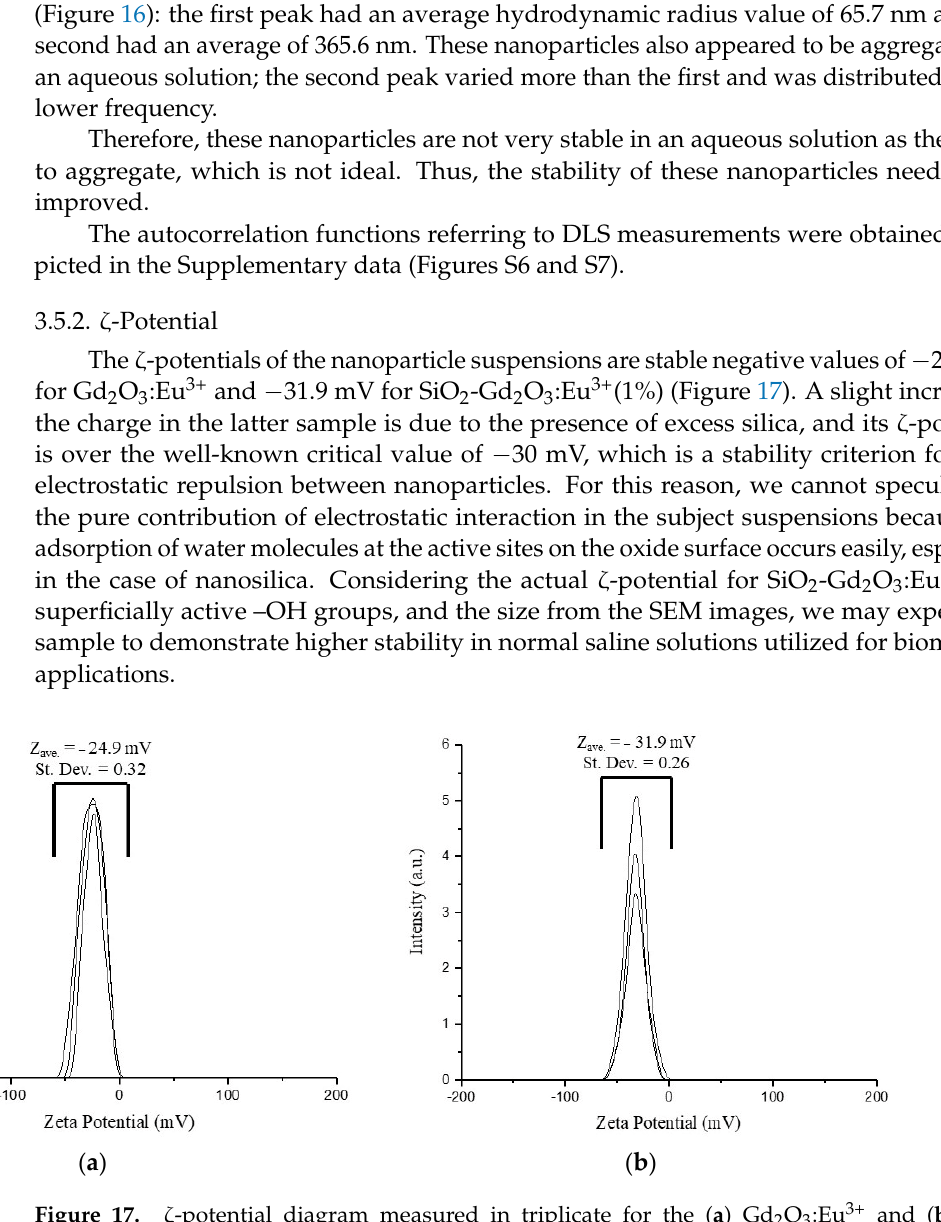
(Figure 16): the first peak had an average hydrodynamic radius value of 65.7 nm and the